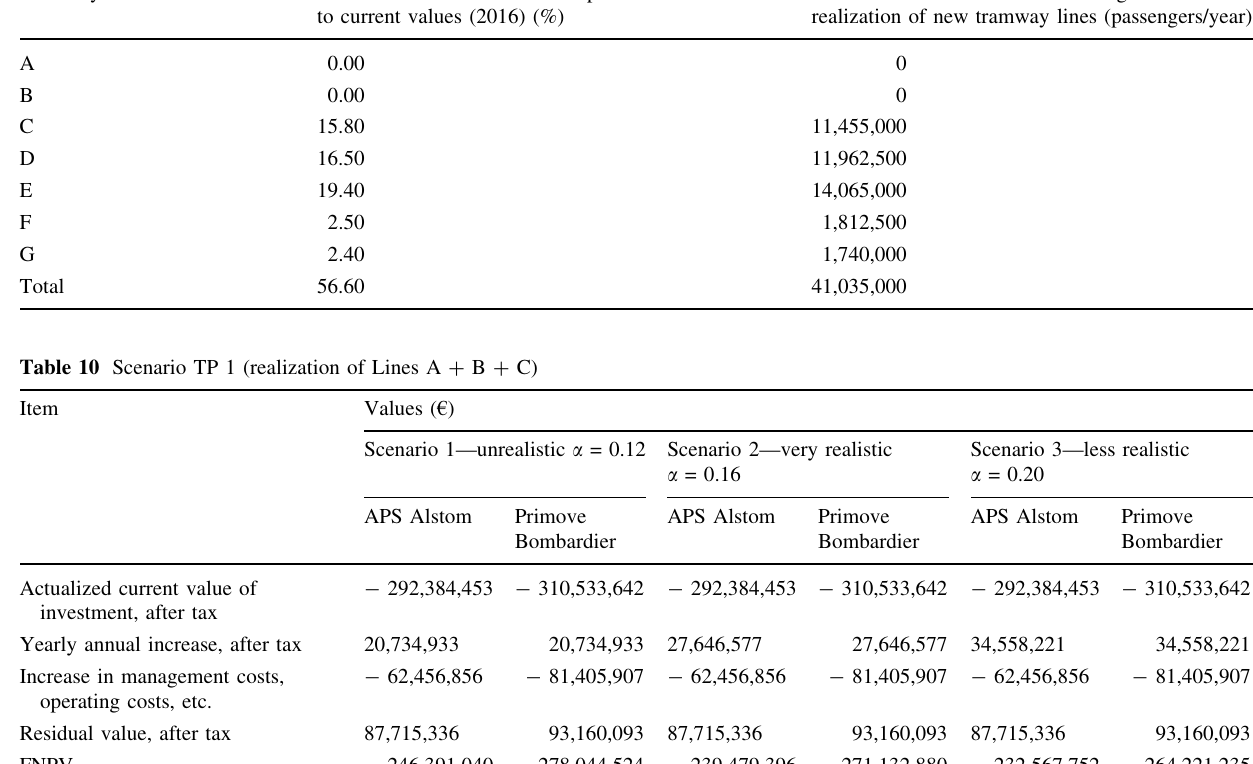
Table 9 Increase in traffic demand following the realization of new tramway lines compared to the counterfactual scenario ‘‘Scenario TP 0’’ of the local public transport service Tramway line